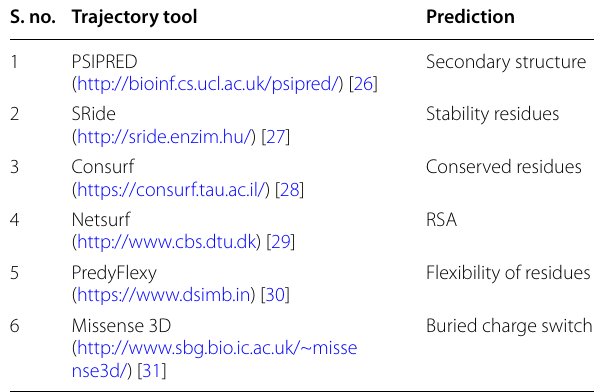
Table 2 List of tools employed for trajectory